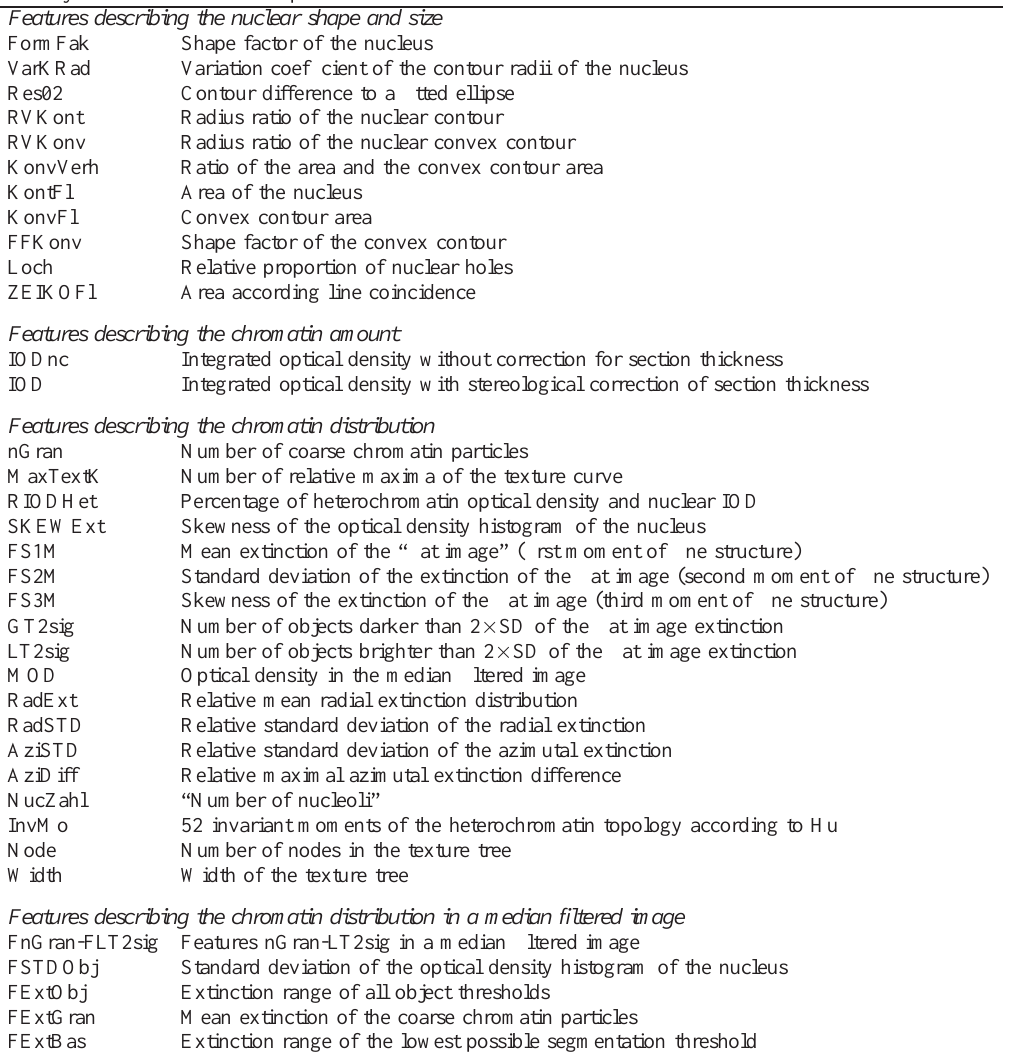
Table 3 Acronyms of the cytometric